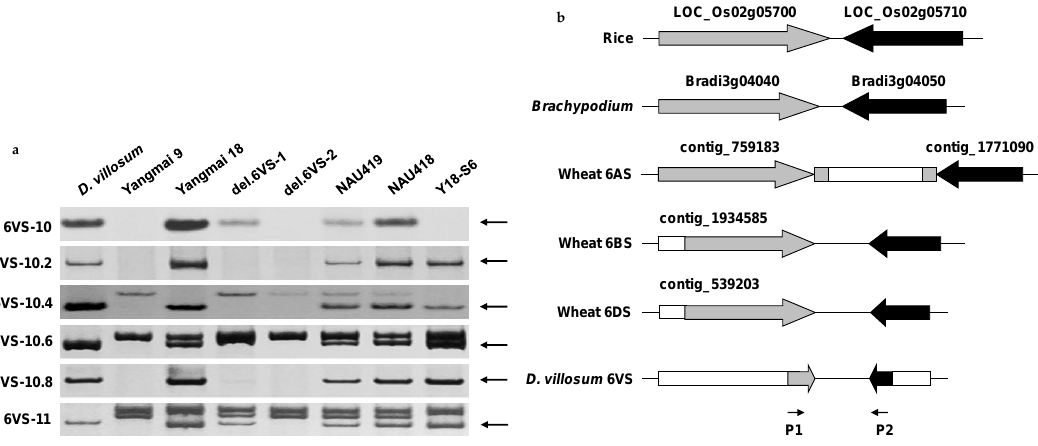
Figure 3. A newfound deletion region of 6VS in del.6VS-1. ( a ) Amplification patterns of the markers 6VS-10, 6VS-10.2, 6VS-10.4, 6VS-10.6, 6VS-10.8, and 6VS-11. The polymorphic DNA bands are pointed by arrows. All the markers 6VS-10.2, 6VS-10.4, 6VS-10.6 and 6VS-10.8 in the bin FLb5–b6, flanked by 6VS-10 and 6VS-11, were deleted in del.6VS-1; ( b ) Linkage relationship between the markers 6VS-10.8 and 6VS-11 in different (sub) genomes. The corresponding orthologous genes of 6VS-10.8 and 6VS-11 are indicated by grey and black arrows, respectively. The unknown sequences are shown in white boxes. On wheat 6AS, the grey boxes at the ends of contig_759183 and contig_1771090 indicate retrotransposon-like repeat sequences of wheat genome. On D. villosum 6VS, the linkage relationship of the corresponding genes of 6VS-10.8 and 6VS-11 were detected by PCR using the primers P1 and P2, and then confirmed by